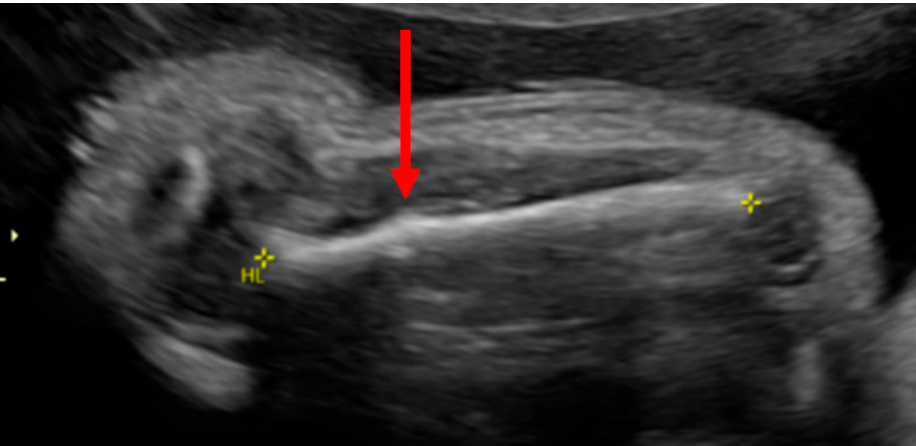
Figure 1. Prenatal ultrasound at 32w1d of gestation. The fetal survey showed a transverse linear fracture line through the proximal right humeral diaphysis with some associated bowing and callus formation. Holick MF, copyright 2021.